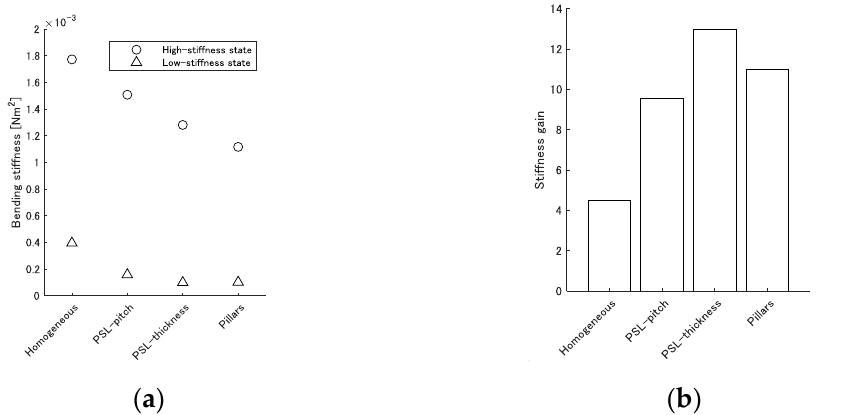
Figure 7. Stiffness of the device in high-stiffness and low-stiffness states ( a ); the stiffness gain ( b ) calculated by simulation for the four conditions. Homogeneous, PSL-pitch, PSL-thickness and Pillars.